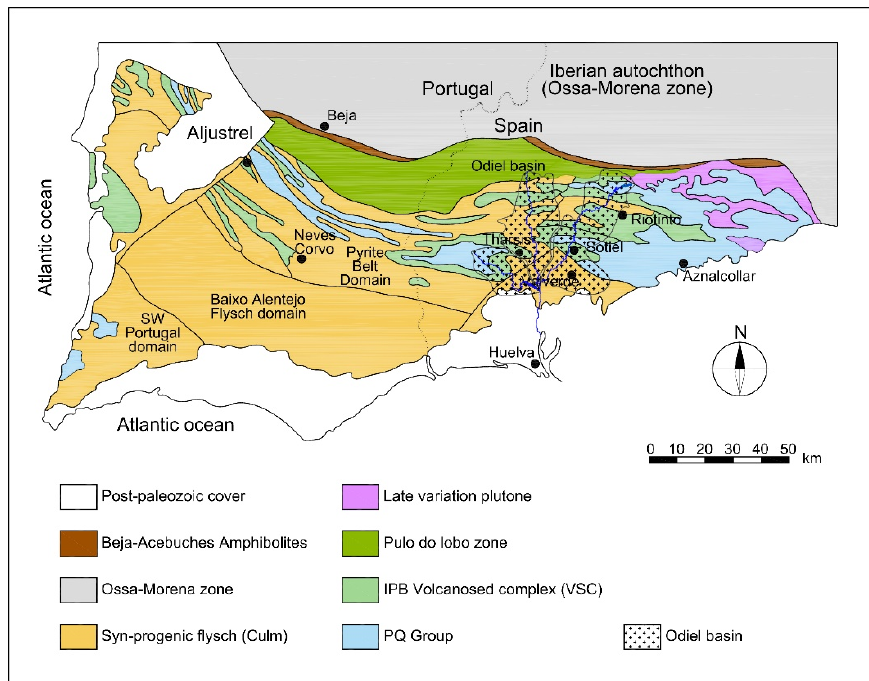
Figure 1. Geological map of the IPB with Odiel Basin marked.